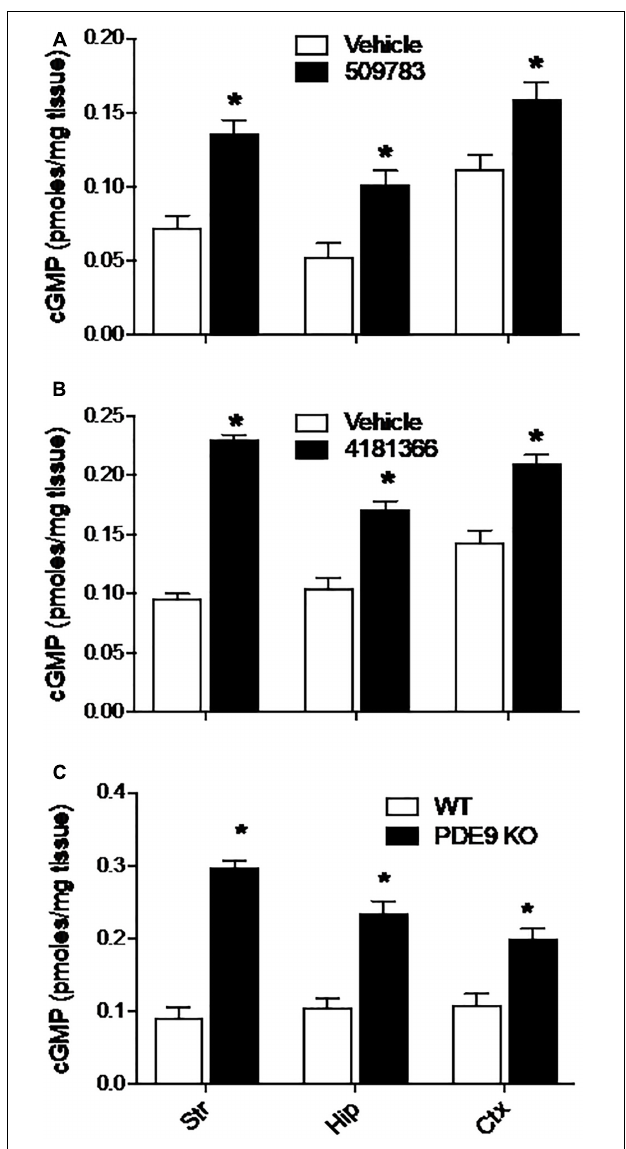
FIGURE 1 | Pharmacological inhibition or genetic deletion of PDE9A elevated brain cGMP. PDE9A inhibitors PF-509783 (A) and PF-4181366 (B) administered 30 min prior to sacrifice induce significant elevations in cGMP content in striatum (Str), hippocampus (Hip), and cortex (Ctx) as compared to vehicle treated controls. PDE9A knockout mice (C) exhibit significant elevations in cGMP content in these same brain regions as compared to wild type littermates. At the doses tested, the effects of the PDE9A inhibitors were similar to that of PDE9A gene knock out. Results were analyzed by two-way ANOVA (Gene status or PDE9A inhibitor X brain region) followed by post hoc tests of the effect of gene status or treatment in each brain region, corrected for multiple comparisons. There was a significant main effect of PF-509783 [ F (1, 24) = 50.34, P < 0.0001], a main effect of brain region [ F (2, 24) = 20.17, P < 0.0001], but no interaction [ F (2, 24) = 0.4869, P = 0.6205]. Subsequent post hoc tests indicated that the increase in cGMP with PF-509783 treatment was statistically significant in all brain regions ( P < 0.05). There was also a significant main effect of PF-4181366 [ F (1, 36) = 249.4, P < 0.0001], a